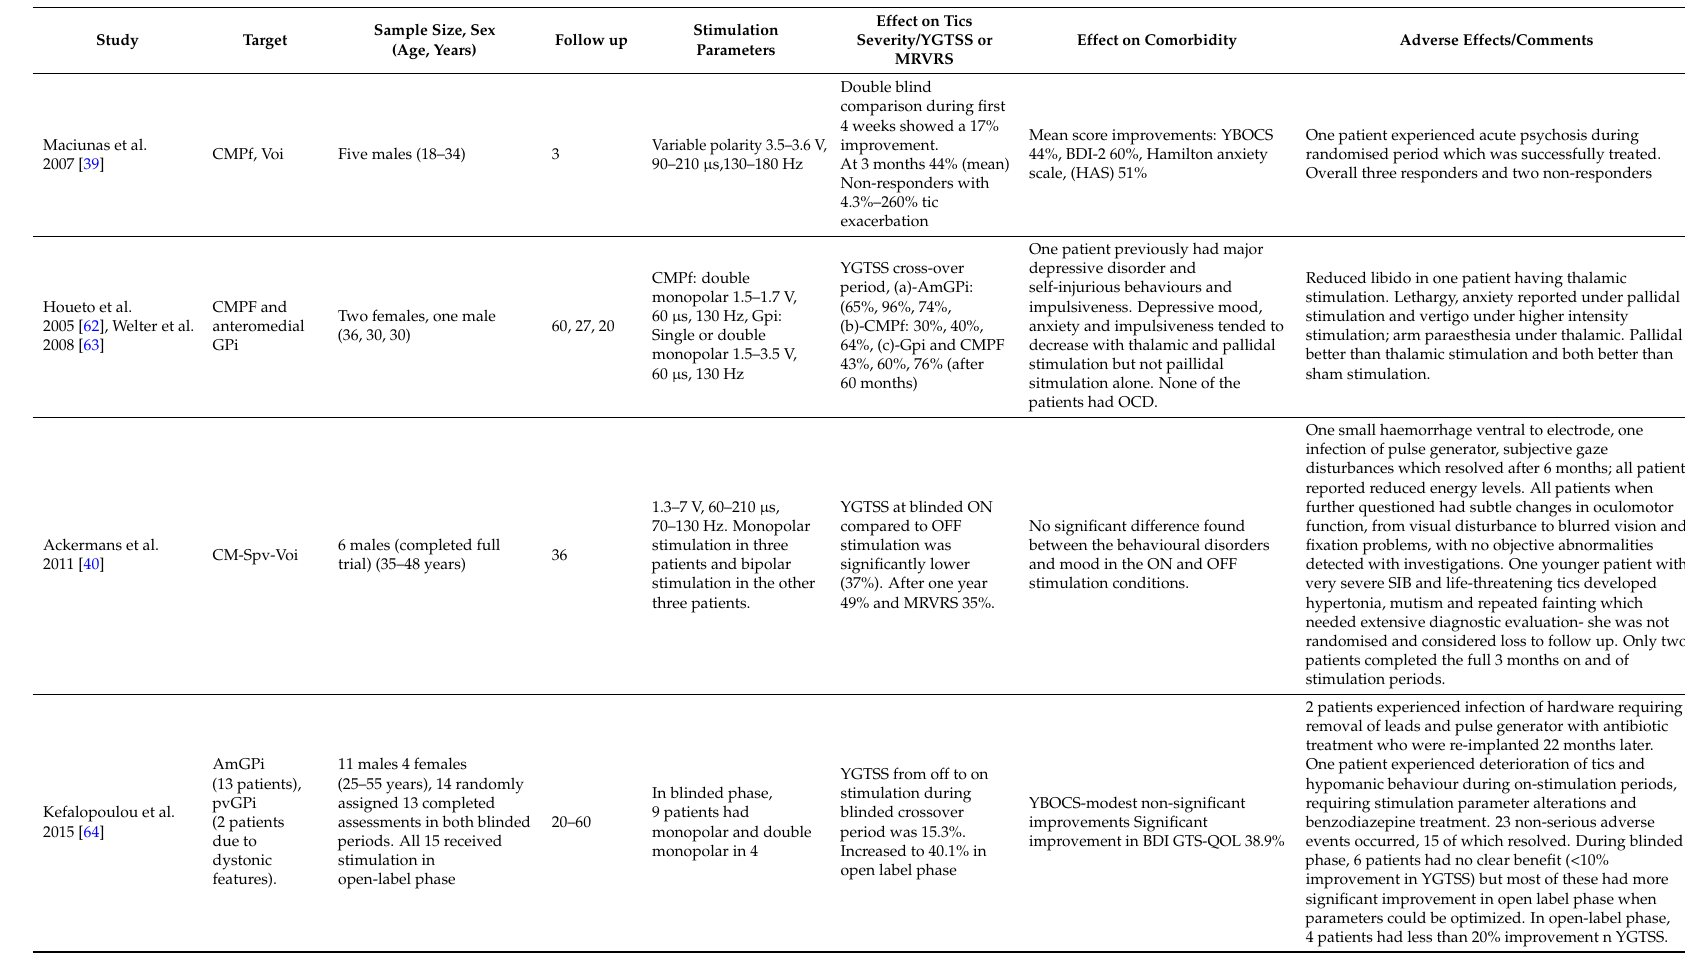
Table 2. Summary of randomised